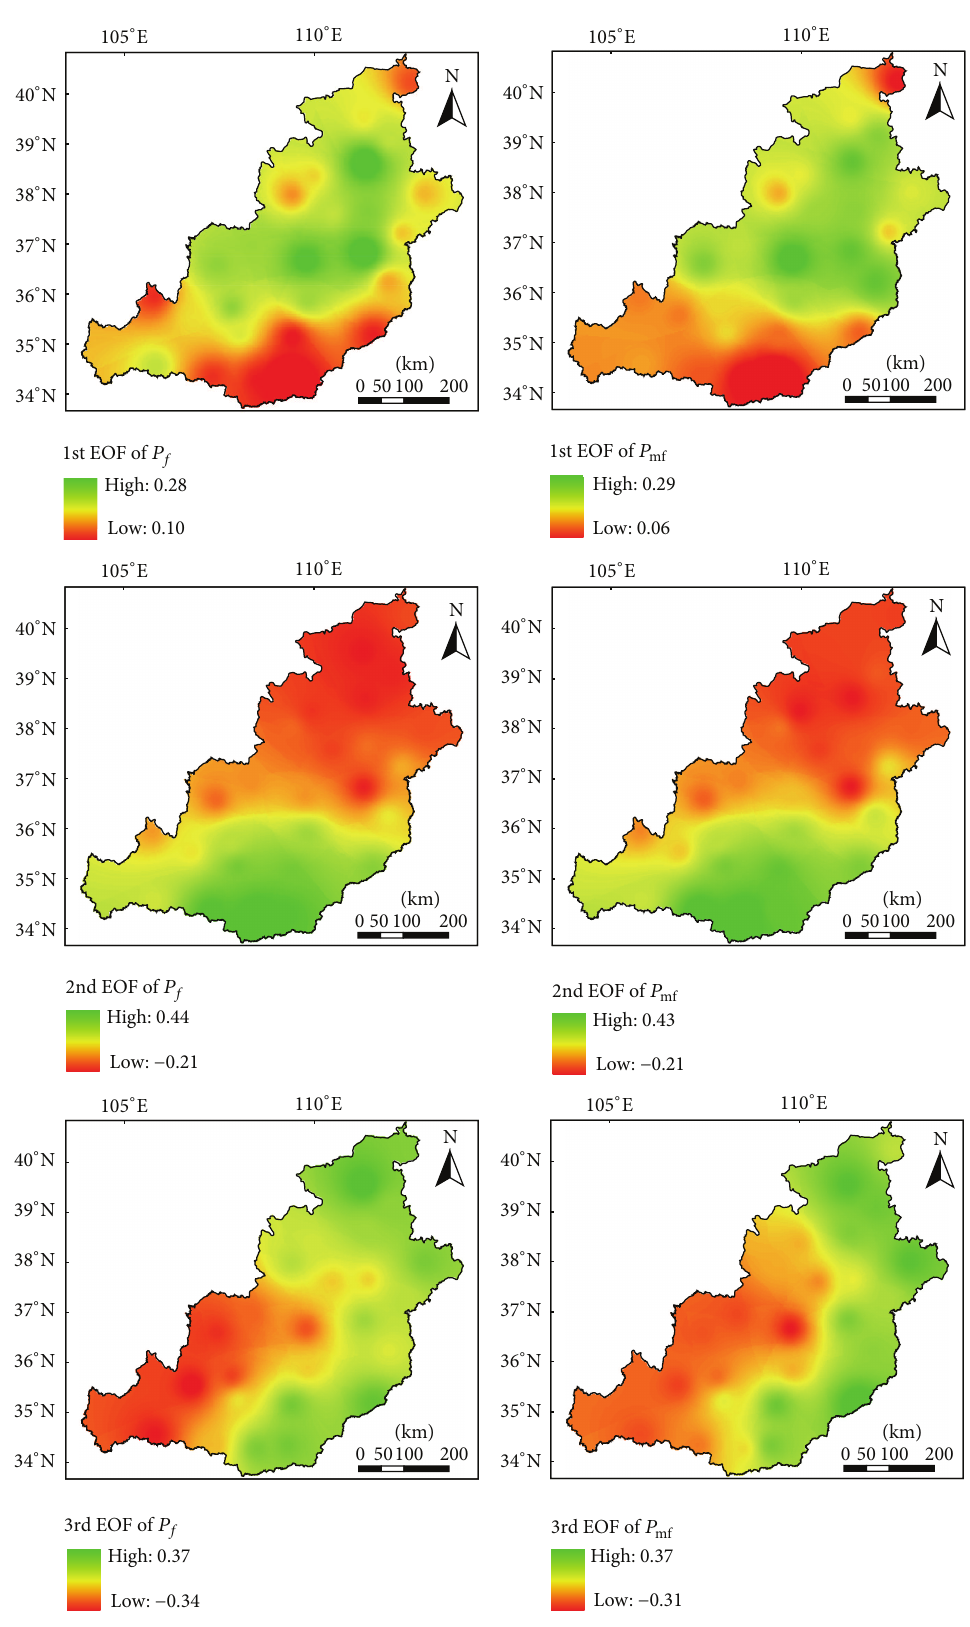
Figure 3: First three EOFs of the 𝑃 𝑓 and 𝑃 mf in